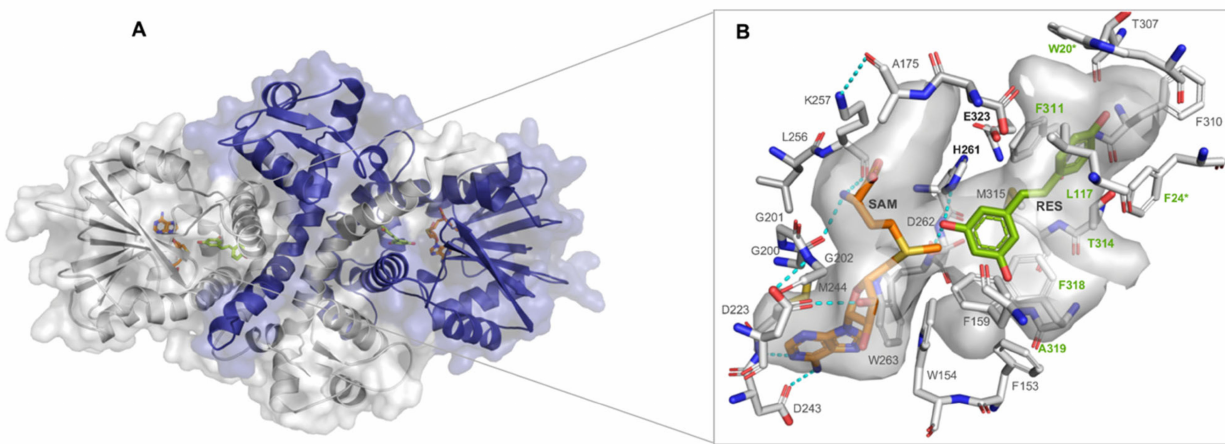
Figure 2. Three-dimensional model of VvROMT. ( A ) The homodimeric closed conformation of the VvROMT model is shown in ribbon representation with semitransparent surface. ( B ) Surface representation of the active site with binding site residues shown as gray sticks. H261 and E323 are the catalytic residues. F24 and W20 (marked with an asterisk) are contributed by the sister monomer and green labeled residues were engineered by site-directed mutagenesis. SAM is shown in orange sticks and resveratrol in green sticks. Predicted hydrogen bonds are shown as cyan dashed lines, and atoms are colored according to their atom type (carbon, grey; nitrogen, blue; oxygen, red; and sulfur, yellow). Image generated with PyMOL version